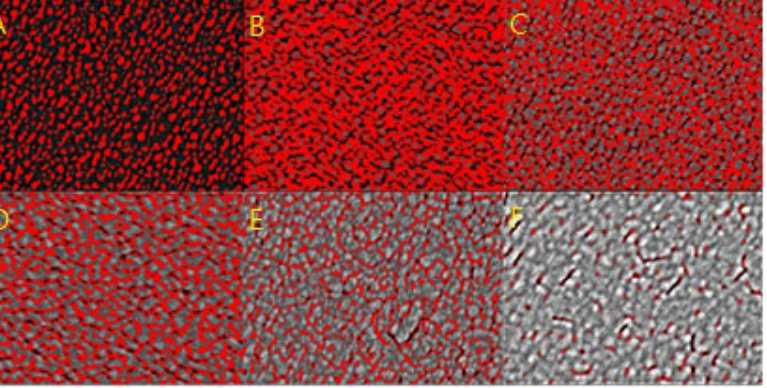
Figure 13. The different hotspot areas on Sample ( A – F ) with the different Ag-deposited thick- nesses.